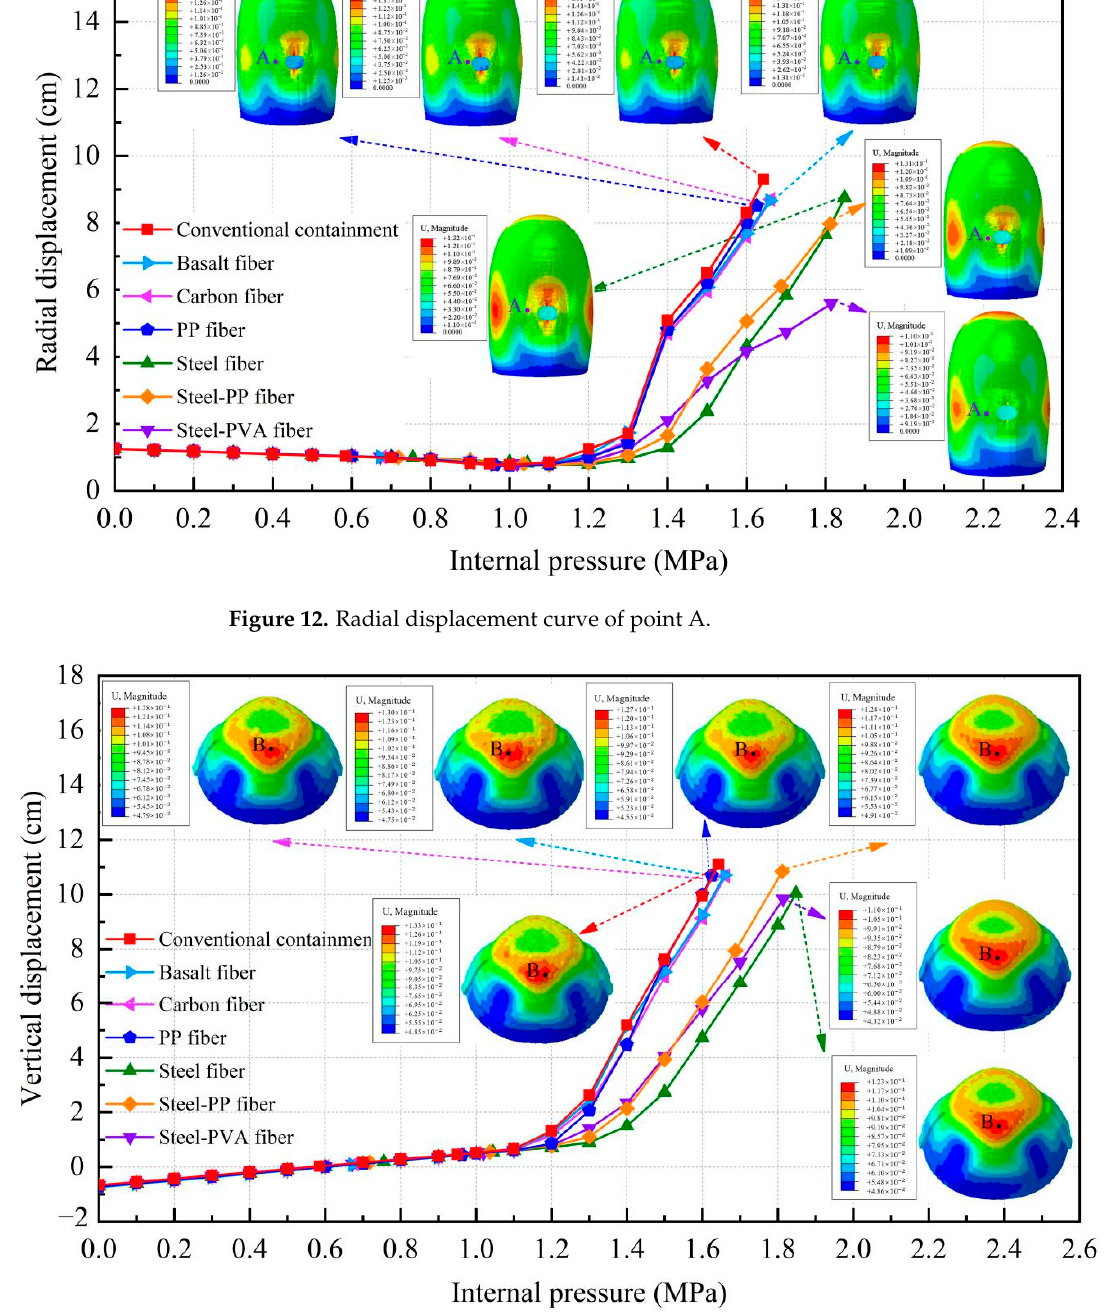
Figure 13. Vertical displacement curve of point B.